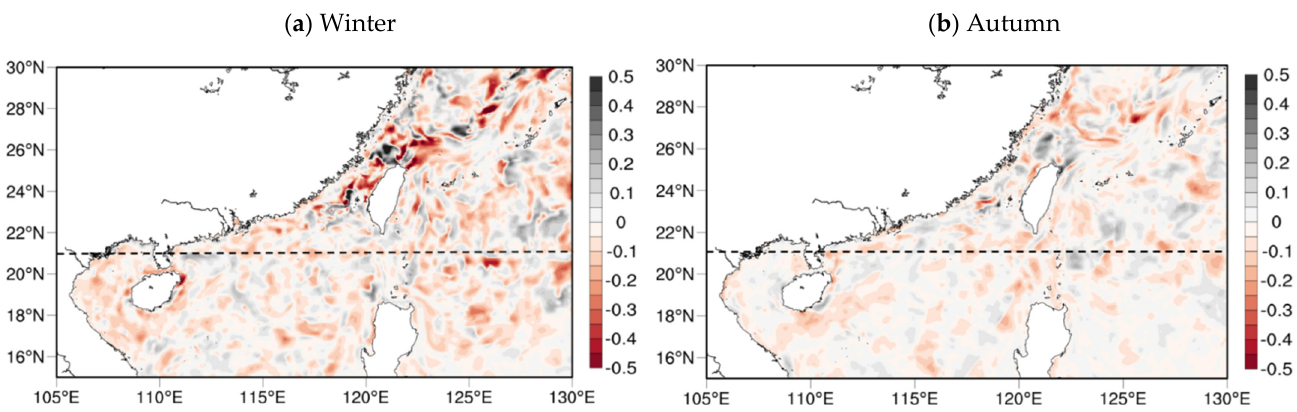
Figure 9. The different distributions of RMSE of EnOI minus RMSE of EnOS in the winter (12, 1, 2) and autumn (9, 10, 11) of 2015.